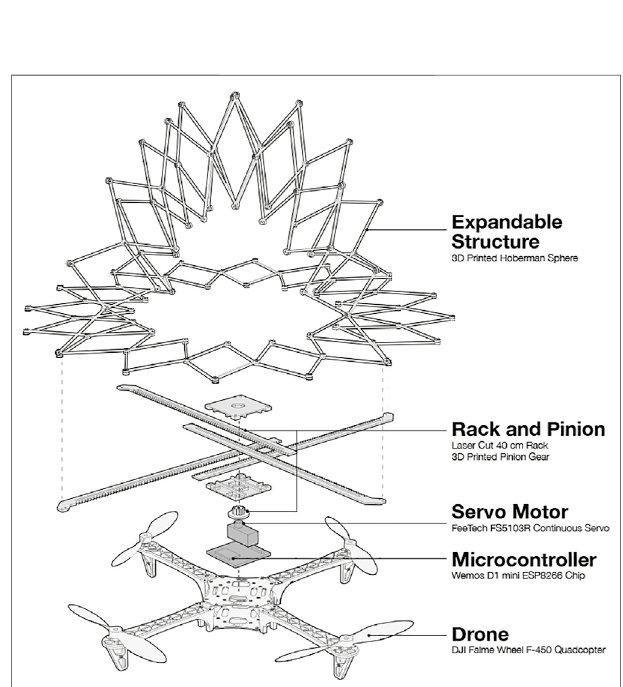
FIGURE 12| The various componentsof PufferBot. Atthe base, we use a DJI Flame Wheel F450 drone. A microcontroller is used to control the actuation mechanism, a servo motor and a rack and pinion mechanism. The racks are joined with the expandable structure to control its radius.